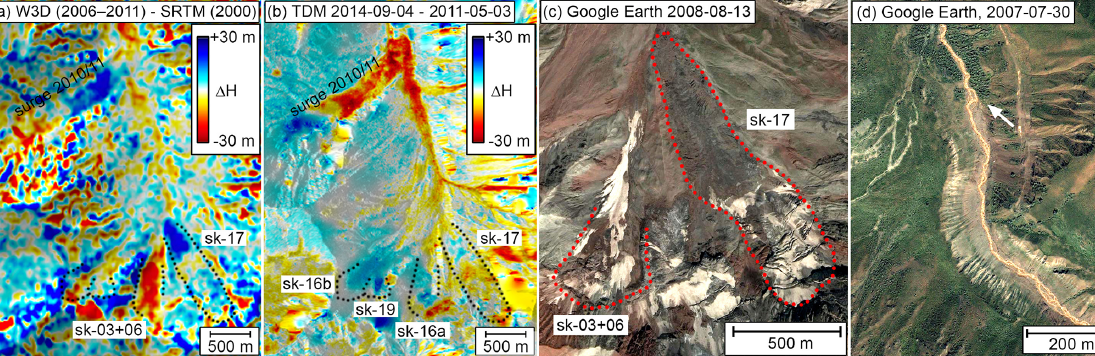
Figure 6. Shuraki Kapali catchment. (a) The W3D–SRTM DEM difference shows a clear height loss (red) where the detachment sk-03 and the ice avalanche sk-06 occurred. A surge-like elevation gain (blue) is visible at the glacier tongue which detached in 2017 (sk-17). (b) The TDM DEM difference shows a nearly stagnant surface height before the sk-17 event. At the confluence of the 2010/11 surge and the valley floor, elevation loss indicates melt of ice and previous mass flow deposits. Panel (c) shows the rupture line of the sk-03 and sk-06 events. (d) The suspected end of the sk-03 avalanche is indicated by existing tall vegetation on the valley floor (arrow). (a) 2020, JAXA and USGS; (b) TanDEM-X. Imagery from (c) and (d) © Google, Maxar